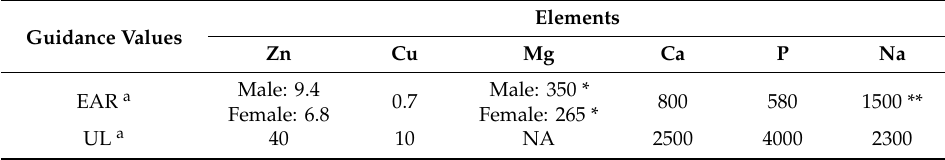
Table 2. Nutritional reference values (mg / d) for zinc (Zn), copper (Cu), magnesium (Mg), calcium (Ca), phosphorus (P), and sodium